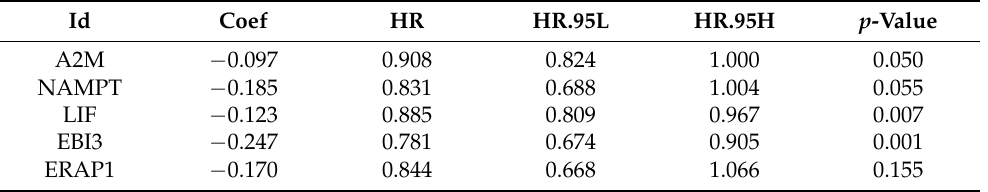
Table 1. The coefficients assessed by multivariate Cox regression.